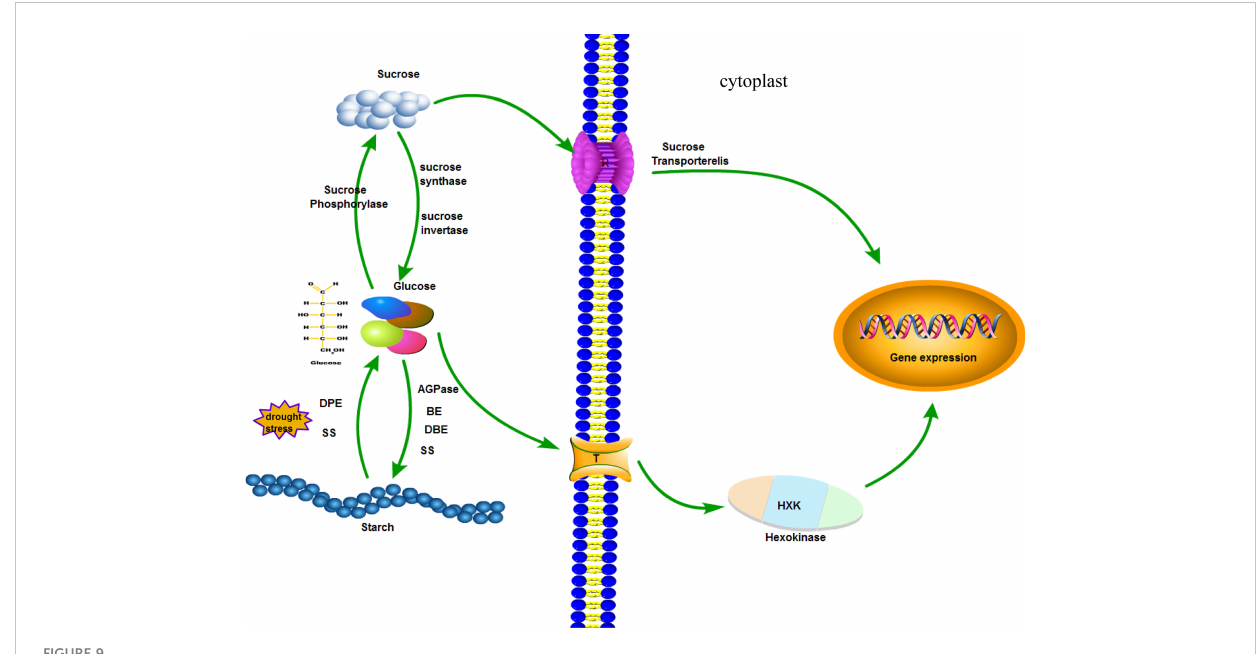
SUPPLEMENTARY TABLE 1 Analysis of Ka/Ks ratios of SS genes in four cotton